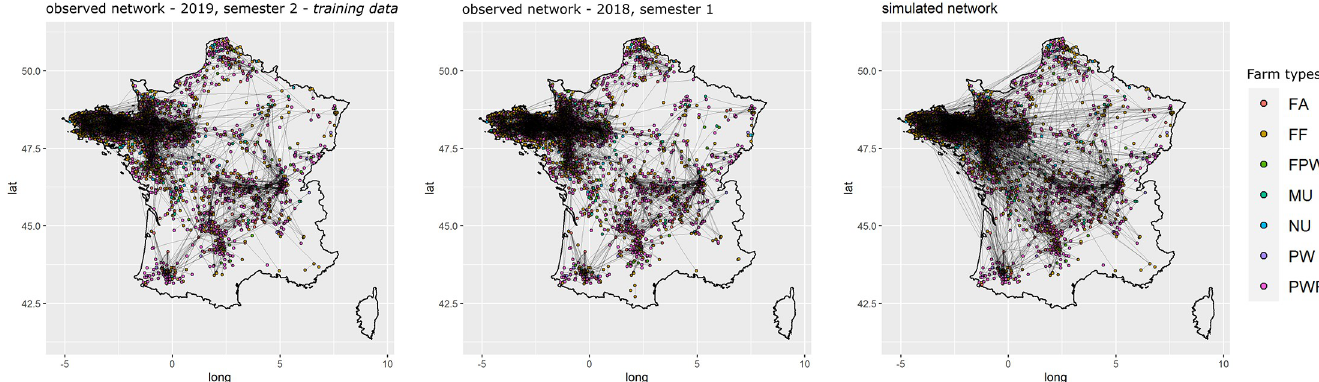
Fig 9. Maps of observed and simulated networks for piglets. Mapping of semestrial networks drawn by the transport of piglets. The network on the left was observed during the second semester of 2019, those data were used to fit the model, the network in the center was observed during the first semester of 2018, and the one on the right was simulated using the fitted exponential random graph